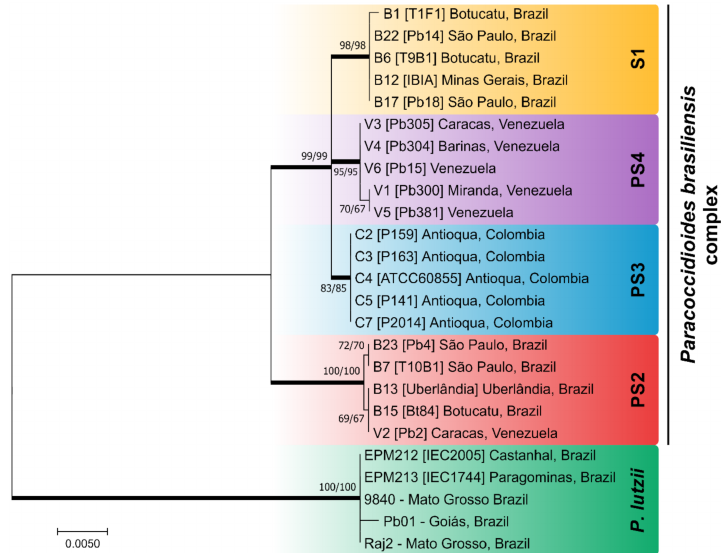
Figure 1. Phylogenetic tree inferred using the maximum likelihood method and Kimura 2-parameter model of the partial sequences of the immunodominant antigen GP43, ADP ribosylation factors (ARF), and tubulin alpha-1 chain (TUB1) of Paracoccidioides isolates. The P. brasiliensis complex is composed of the cryptic species S1, PS2, PS3, and PS4. Paracoccidioides lutzii appear as a divergent genetic group, apart from the P. brasiliensis complex. Numbers close to the branches represent bootstraps values (maximum likelihood / neighbor joining, respectively). Bootstraps higher than 80 based on 1000 replications are represented in bold branches. Sequences were described previously by Matute et al. [14], Teixeira et al. [15], and Hahn et al. [20].